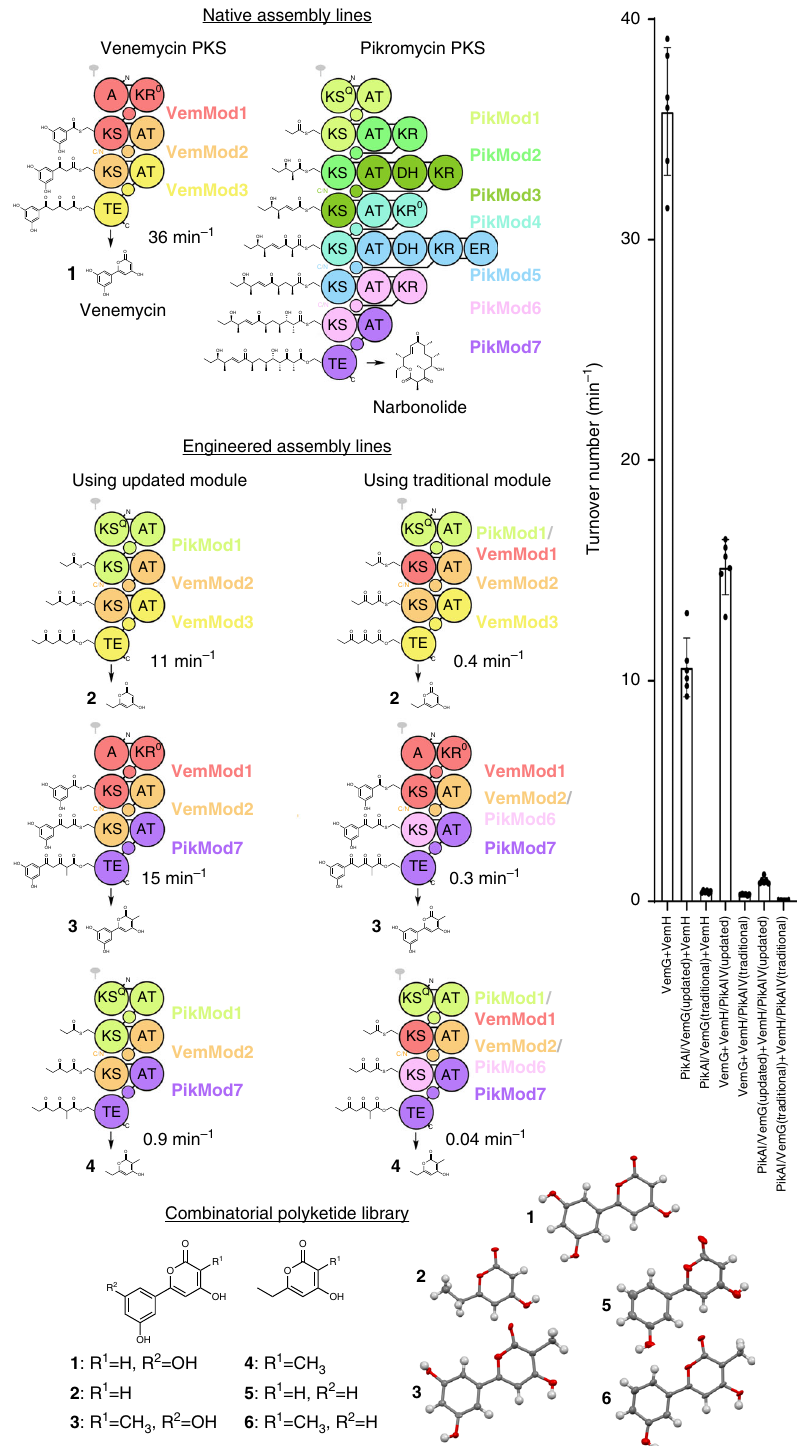
Fig. 4 Engineering and harnessing polyketide assembly lines. The venemycin and pikromycin synthases are combined to yield several hybrids. Assembly lines designed using the updated module boundaries outperform those using the traditional module boundaries by over an order of magnitude (25- and 48- fold, data are mean ± s.d., n = 6 independent experiments). A combinatorial library of 6 products ( 1 – 6 ) is accessed through the engineered synthases and through the alternative starter unit, 3-hydroxybenzoic acid (crystal structures shown in thermal elipsoids). Source data are provided as a Source Data fi le.